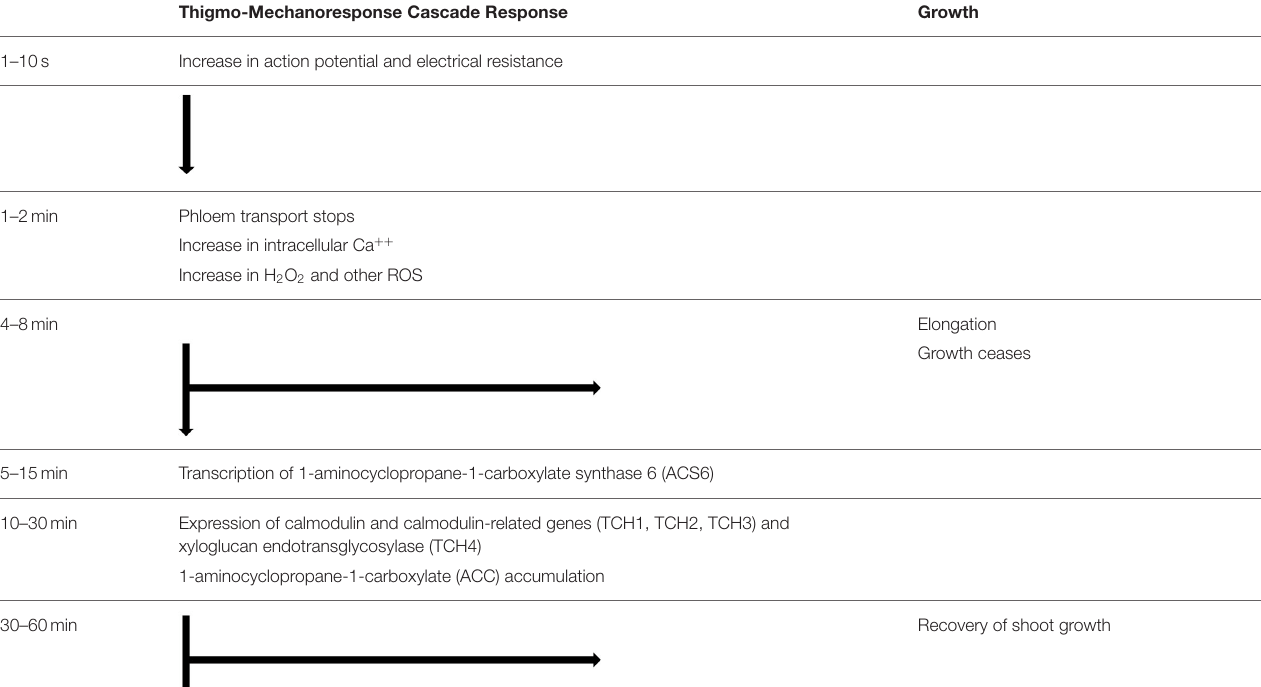
TABLE 1 | Thigmo-mechanoresponse cascade flow diagram of the physiological responses after the induction of a mechanical perturbation. Thigmo-Mechanoresponse Cascade Response